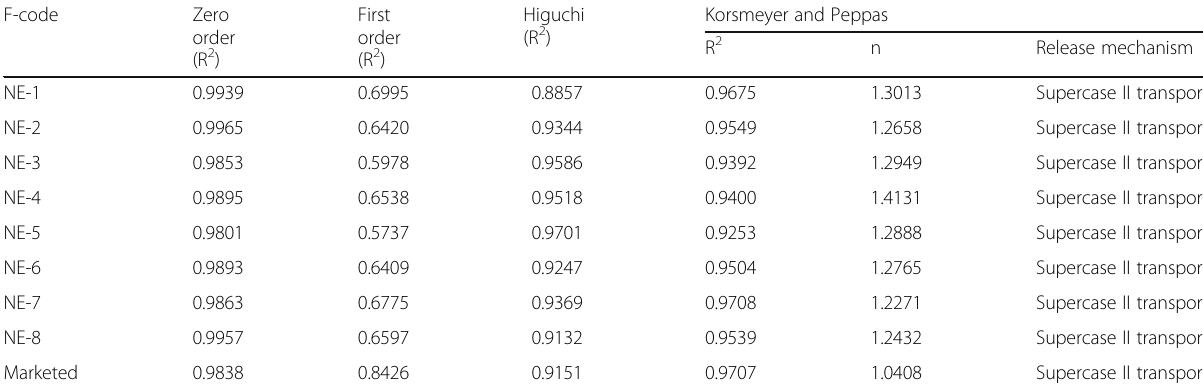
Table 8 Release kinetics study of candesartan cilexetil form nanoemulsions F-code